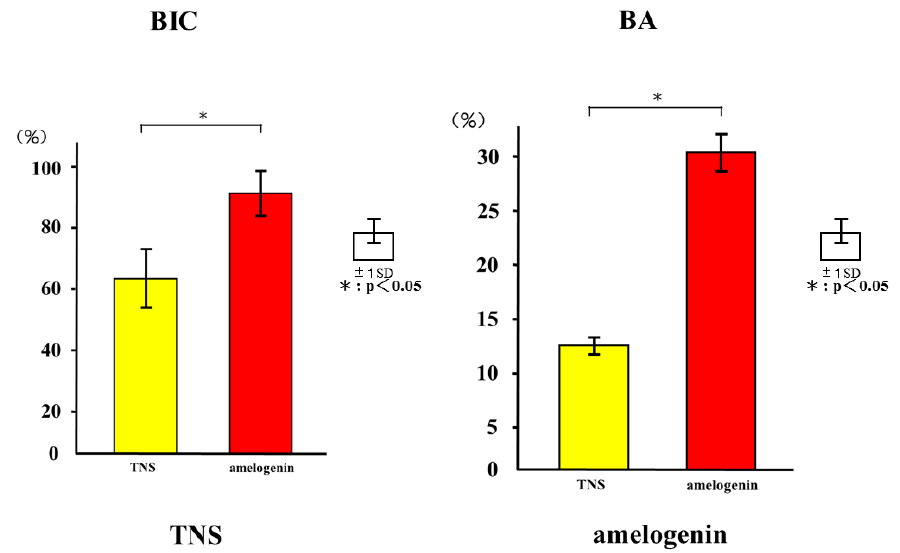
Figure 15. Quantitative histomorphometric analysis within the region of measurement above (BIC and BA). * p < 0.05.